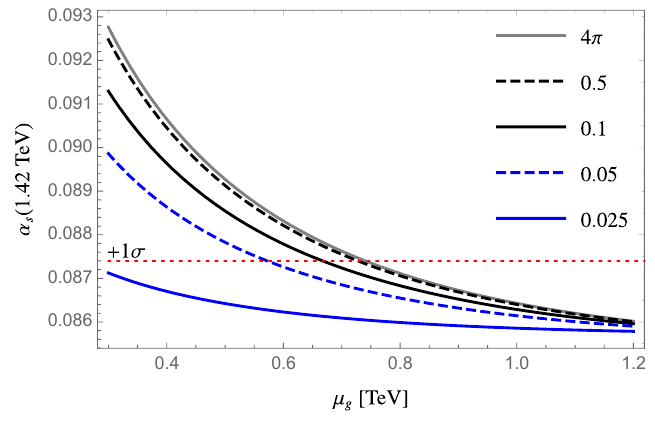
Figure 15 . Bound from running (cid:11) s from the gluon continuum scale (cid:22) g to Q = 1 : 42 TeV. (cid:11) . Results with di(cid:11)erent UV-brane localized values of (cid:11) s gluon continuum scales above (cid:22) = 600{700 GeV are generically safe from the 1 (cid:27) -high value of (cid:11) (1 : 42 TeV). The value of (cid:11) s